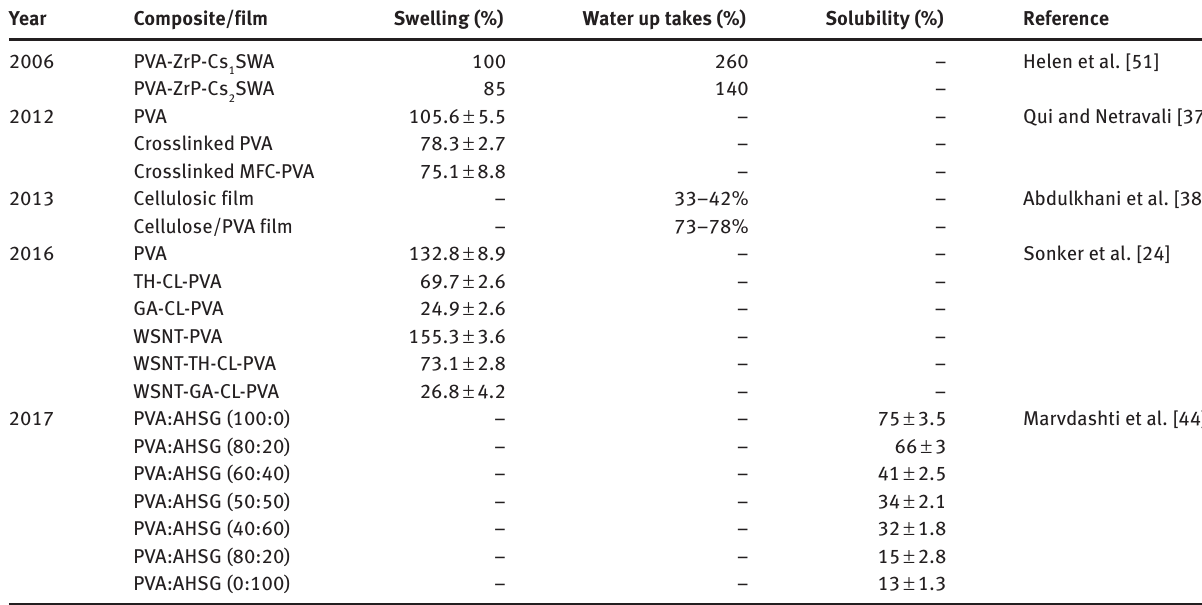
Table 3: Swelling, water uptake and solubility of different